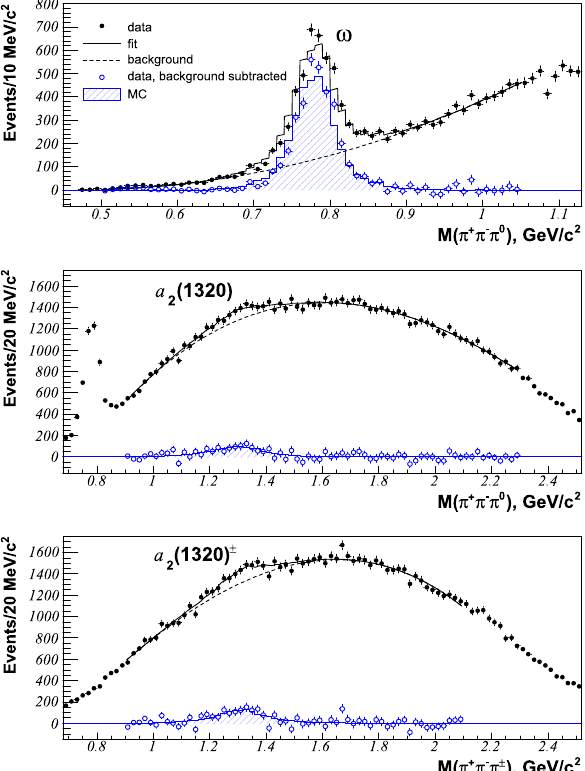
Fig. 3 Masses of π + π − π 0 and π + π − π ± in selected signal events of J /ψ → 2( π + π − )π 0 decays (all combinations per event are shown). Closecirclesareexperimentaldata,blacksolidlinesarethesumsofMC histograms for the corresponding decays through resonances (hatched histograms) and backgrounds (dashed lines), open circles are the data after subtracting of backgrounds